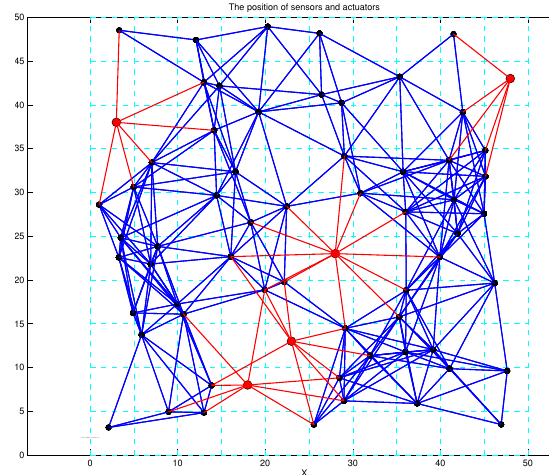
Figure 10. The wireless sensors and actuators’